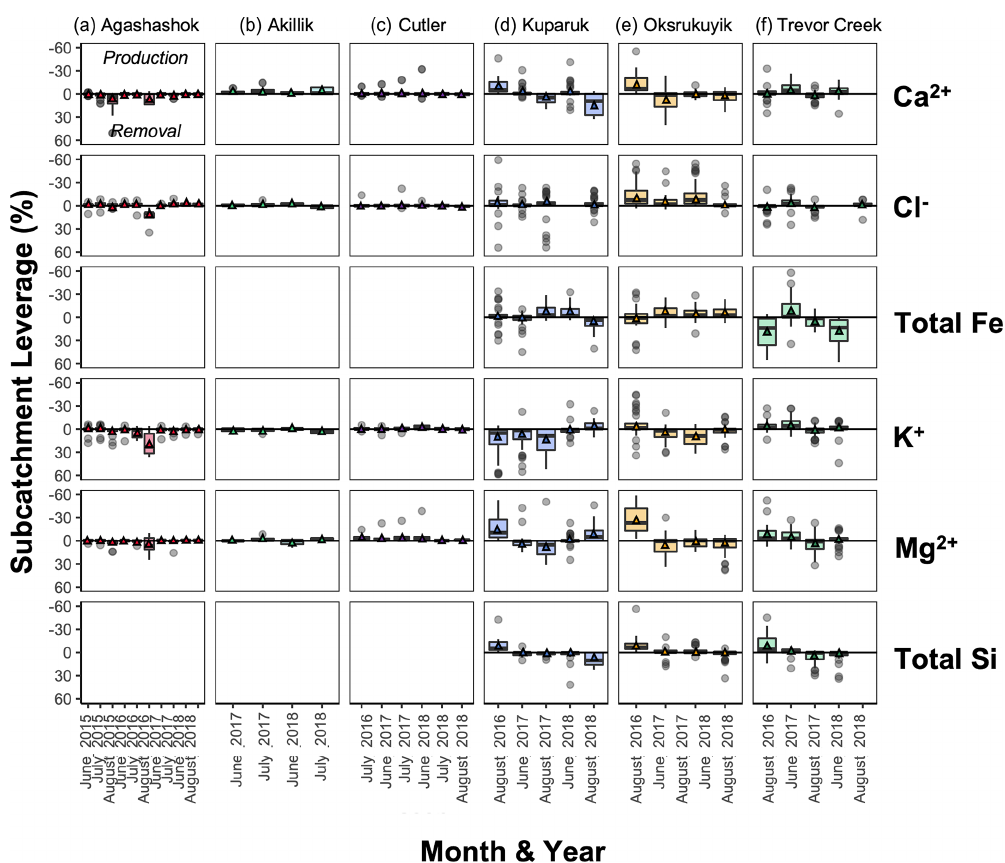
Figure 7. Boxplot of subcatchment leverage for select conservative solutes (Ca 2 + , Cl − , Fe (total for NPS/USGS; nominally dissolved for TFS), K + , Mg 2 + , and total Si) in the (a) Agashashok River, (b) Akillik River, (c) Cutler River, (d) Kuparuk River, (e) Oksrukuyik Creek, and (f) Trevor Creek watersheds across all years and seasons sampled. Note reversed axes for ease of interpretation: negative values above the 0 line indicate production; positive values below the 0 line indicate removal. Each box encapsulates values within the lower 25th and upper 75th quartiles respectively, while the whiskers represent the minimum and maximum quartiles. Within each box, the horizontal line represents the median leverage value and the colored triangle lies at the mean. Data points outside the whiskers represent values above and below 1 . 5 × the IQR